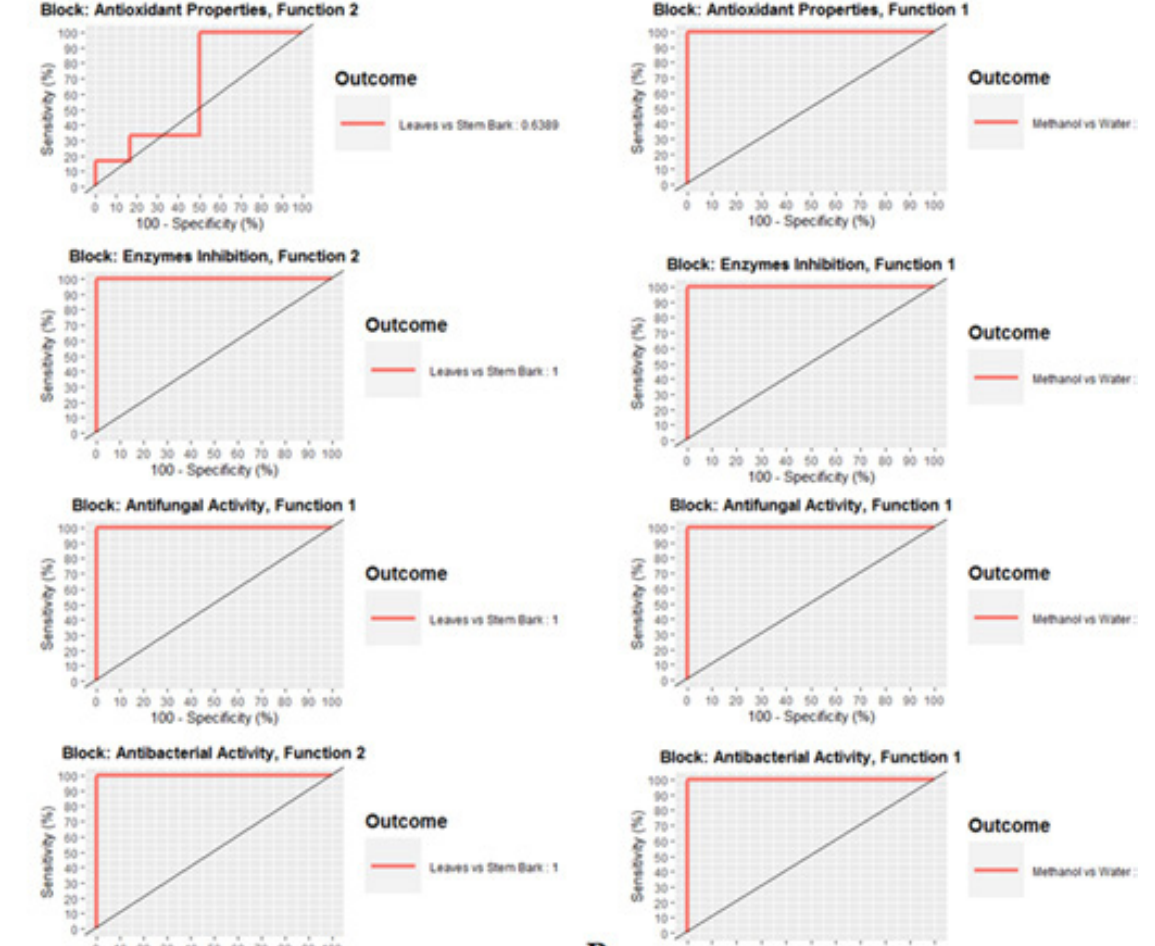
Figure 6. Goodness of the models assessment by Area Under the Curve average using one-vs-all comparisons. ( A ): model 1 (Leaves versus Stem bark). ( B ): model 2 (Methanol versus Water).